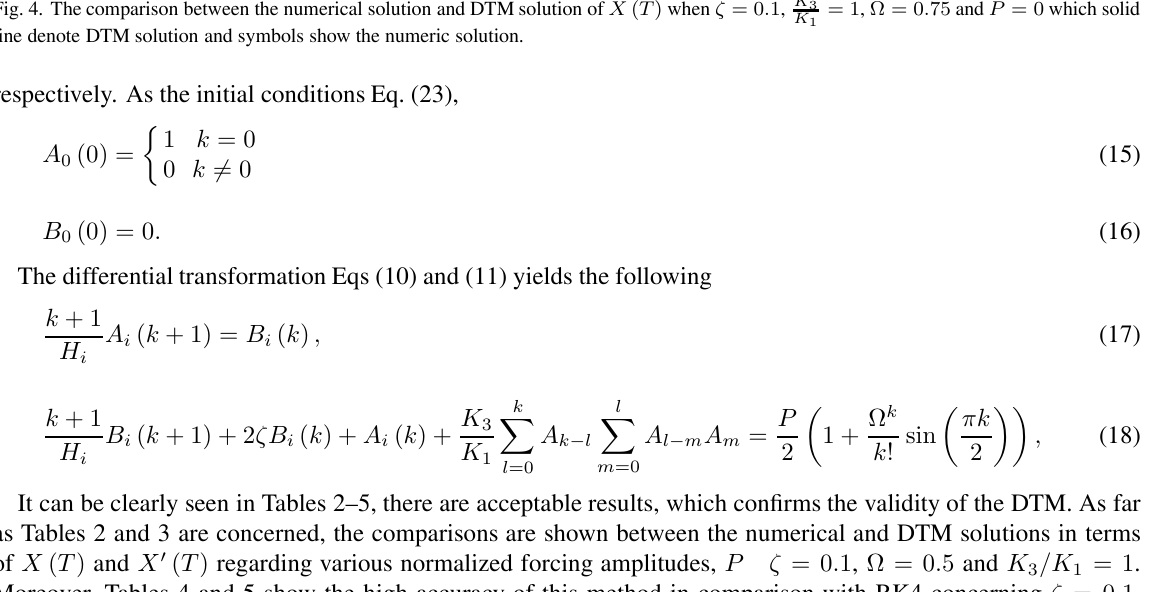
= 1 , Ω = 0 . 75 and P = 0 which solid 1